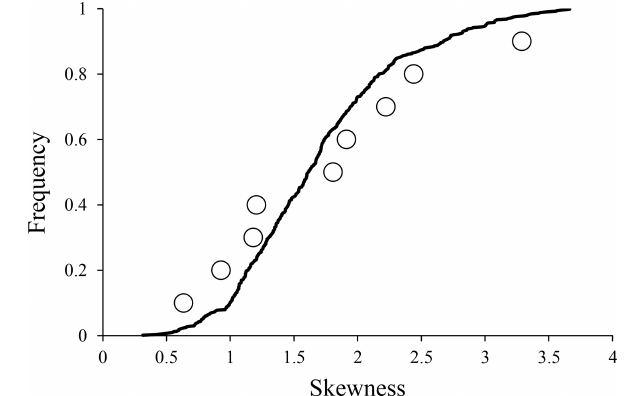
Figure 3. Comparison between the empirical CDF of the skewness coefficient calculated from the nine datasets and the regional CDF obtained from the theoretical distribution.